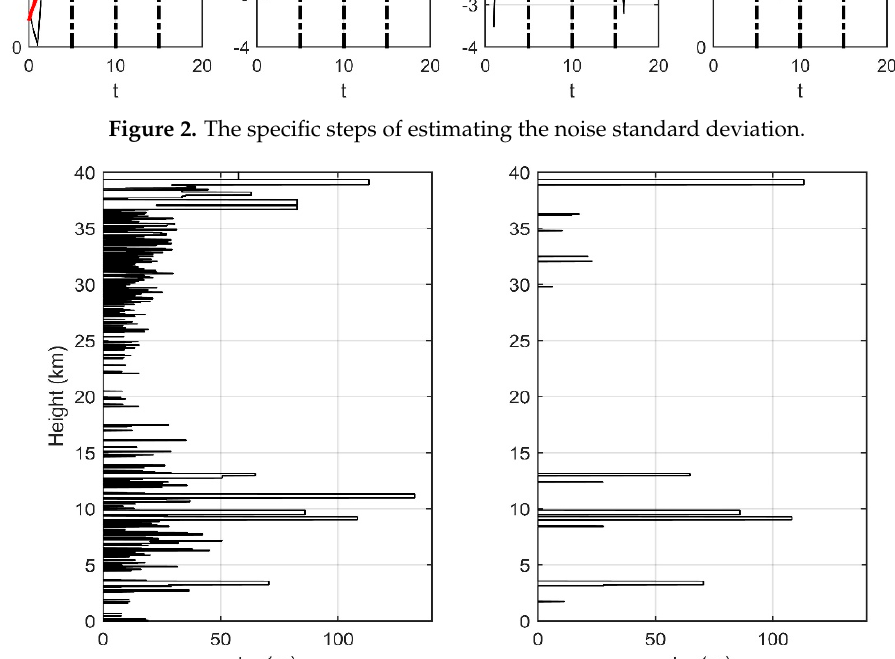
Figure 3. Thorpe length before denoising ( left ) and after denoising ( right ).